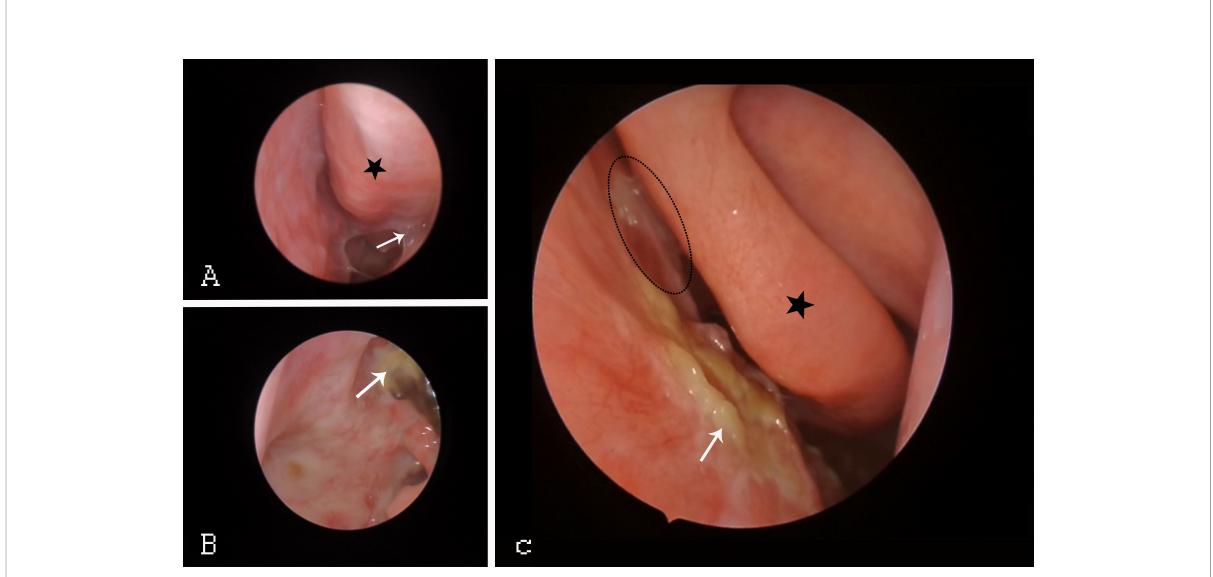
FIGURE 2 Endoscopic changes in NPC patients after RT. (A) Black star: congested IT. White arrow: adhesions throughout the nasal tract. (B) White arrow: pharyngeal fossa in the nasopharynx. (C) Black asterisk: MT. White arrow: middle nasal tract with purulent secretions and scabs. Black ellipse: middle nasal tract with nasal adhesions. IT, inferior turbinate; MT, middle turbinate.